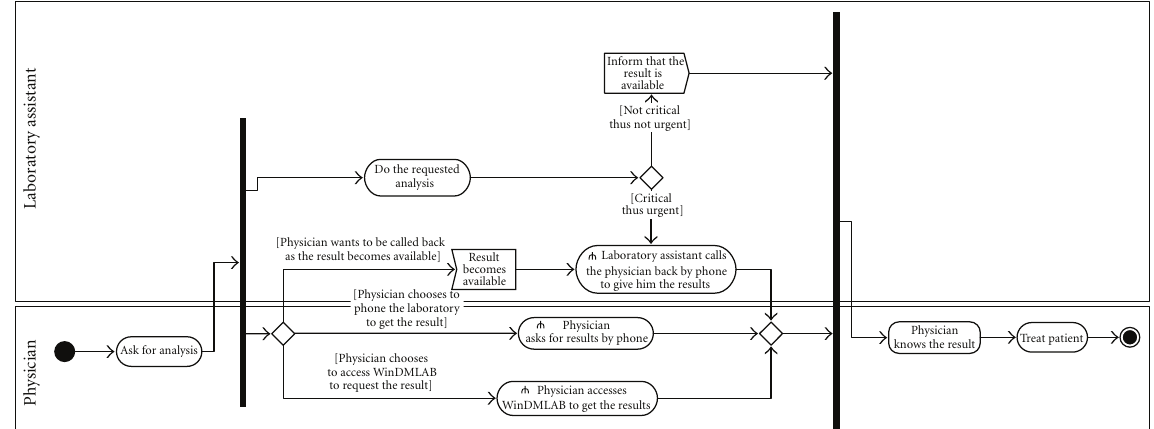
Figure 9: The business processes of the HCF laboratory.